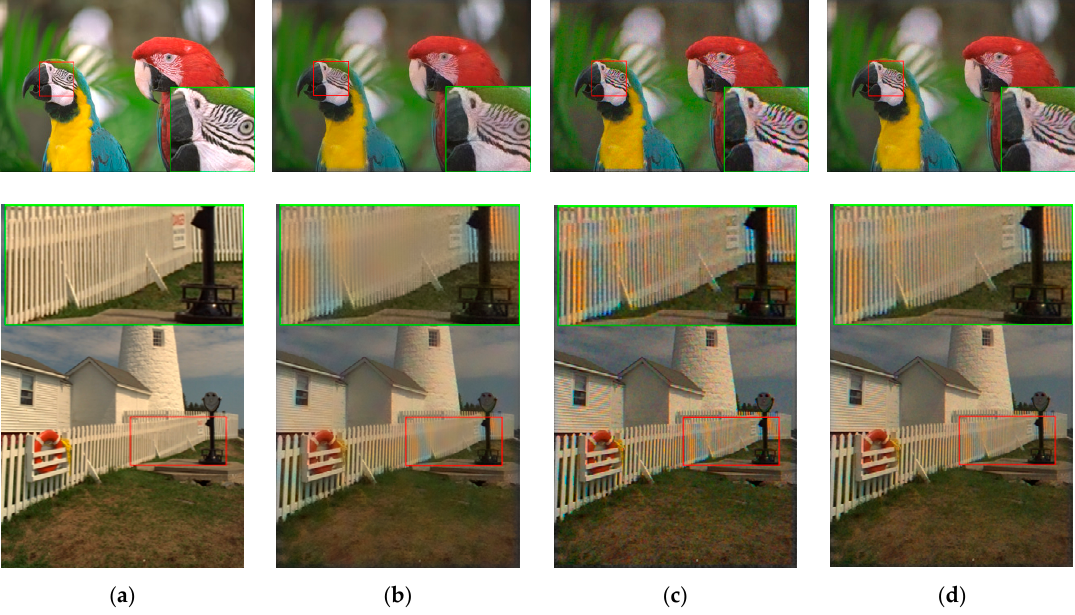
Figure 15. Visual comparison of three high performing demosaicing algorithms at 20 dBs SNR (Poisson